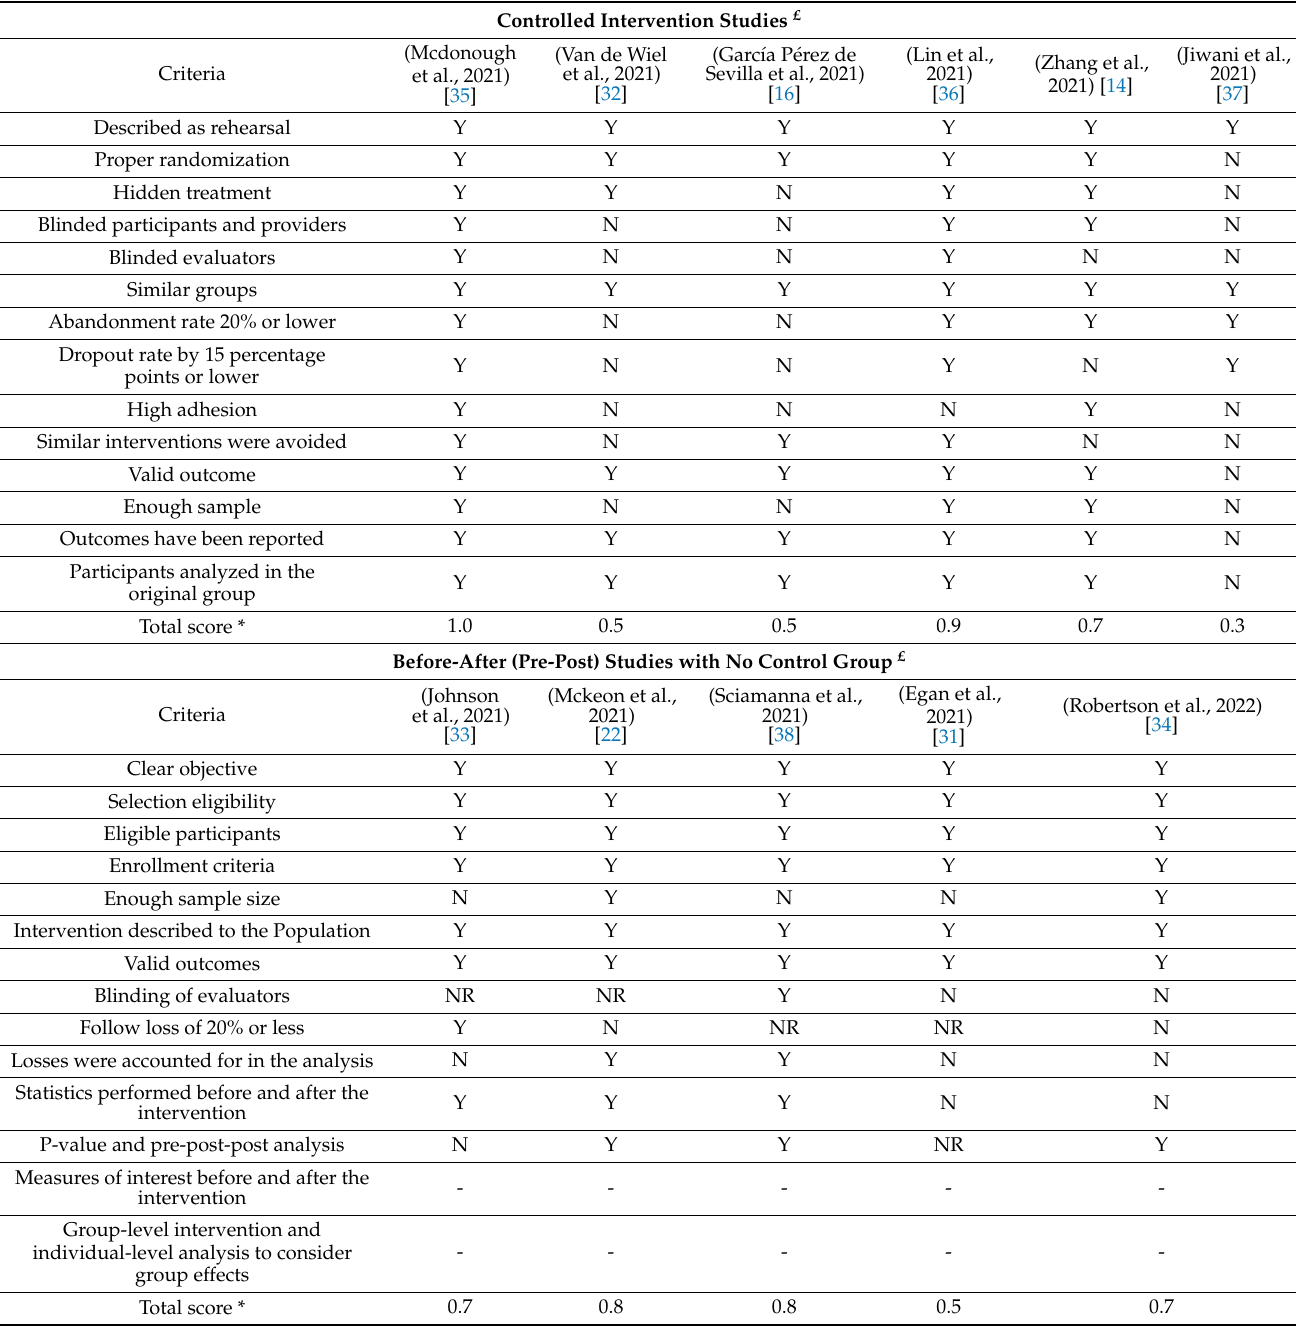
Table 3. Assessment of the methodological quality of the studies included in the scoping